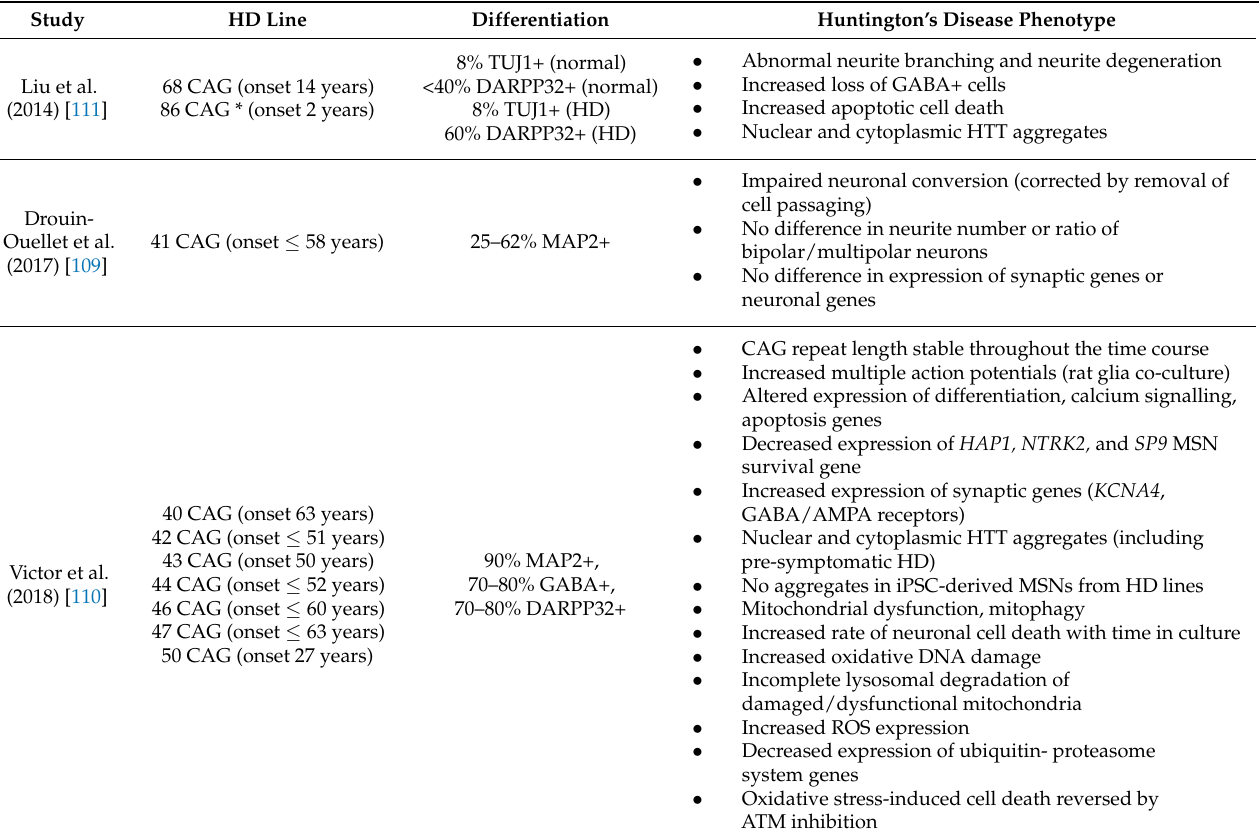
Table 6. Phenotypes observed in Huntington’s disease directly induced